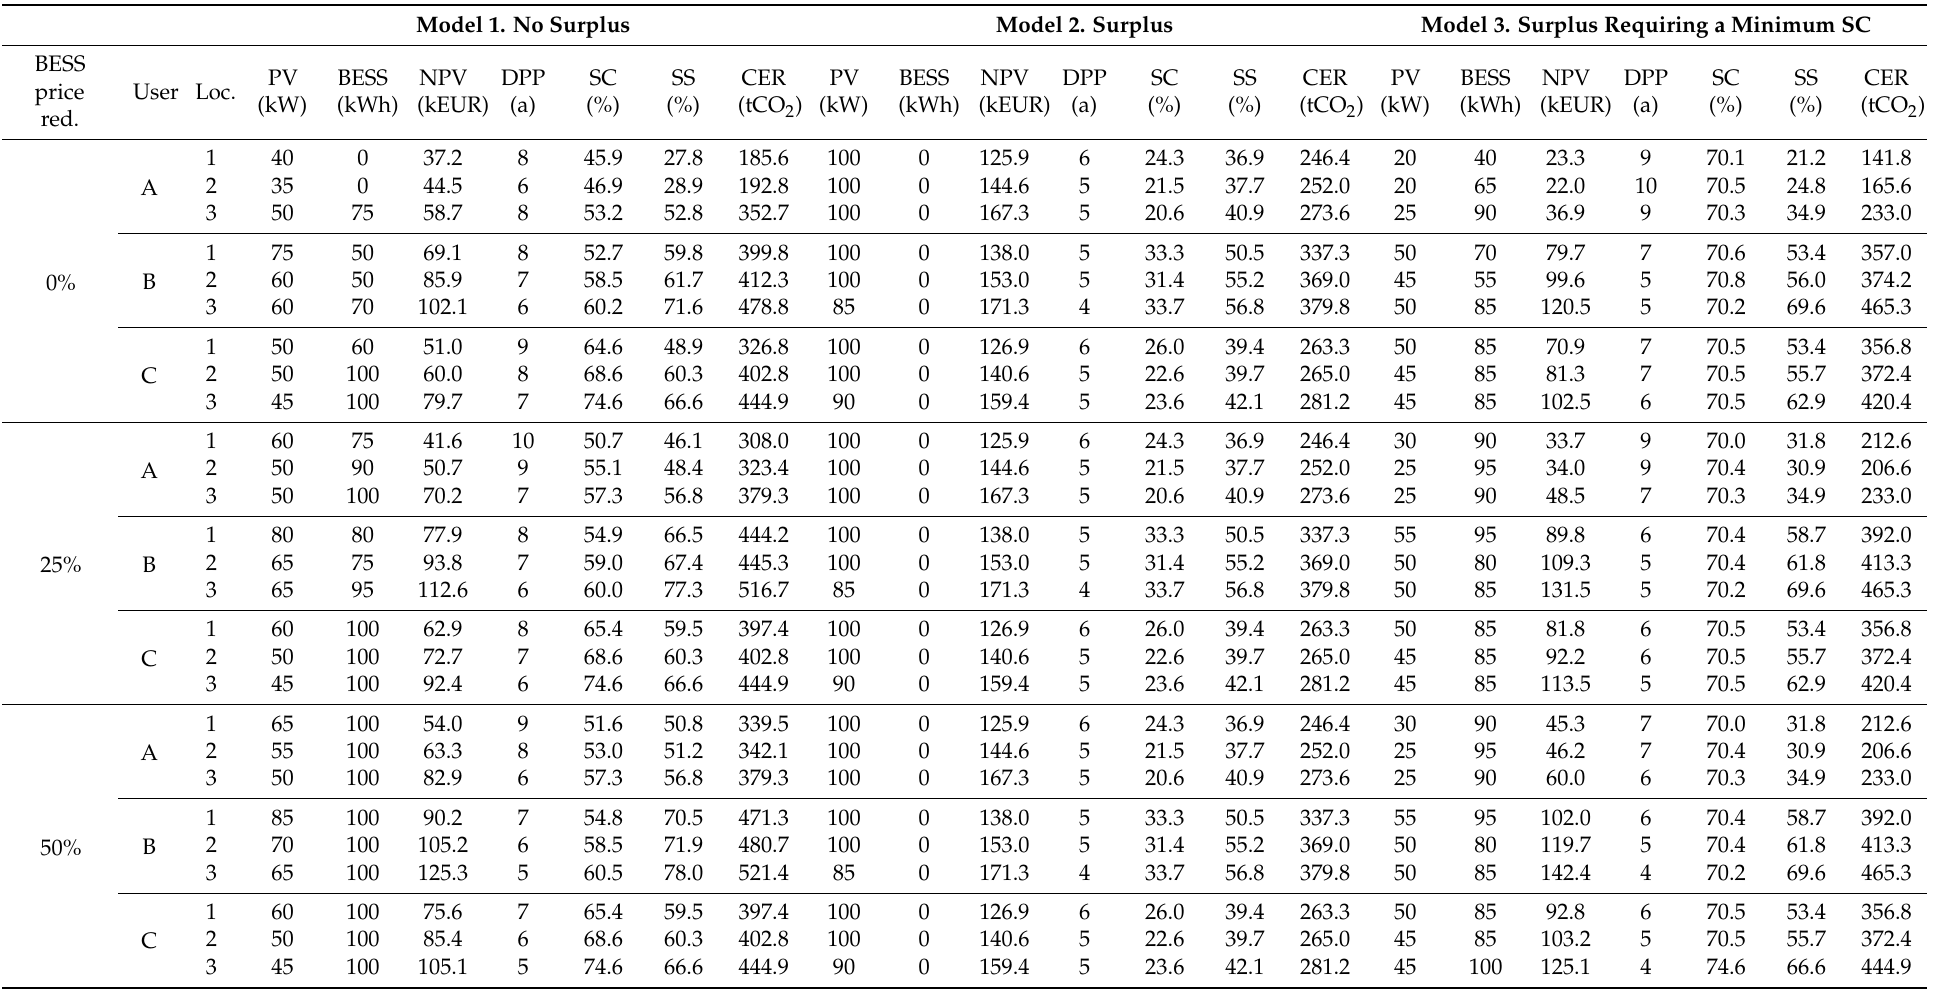
Table 5. Results of the techno-economic simulation and optimization process. (BESS price red.: BESS price reduction; Loc: location; PV: peak PV power; BES: